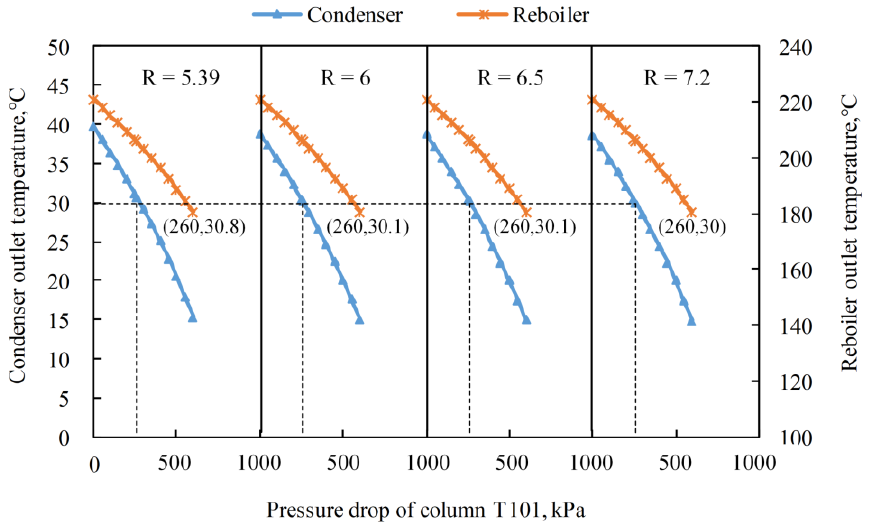
Figure 11. Condenser and reboiler outlet temperatures under different reflux ratios and operating pressures.